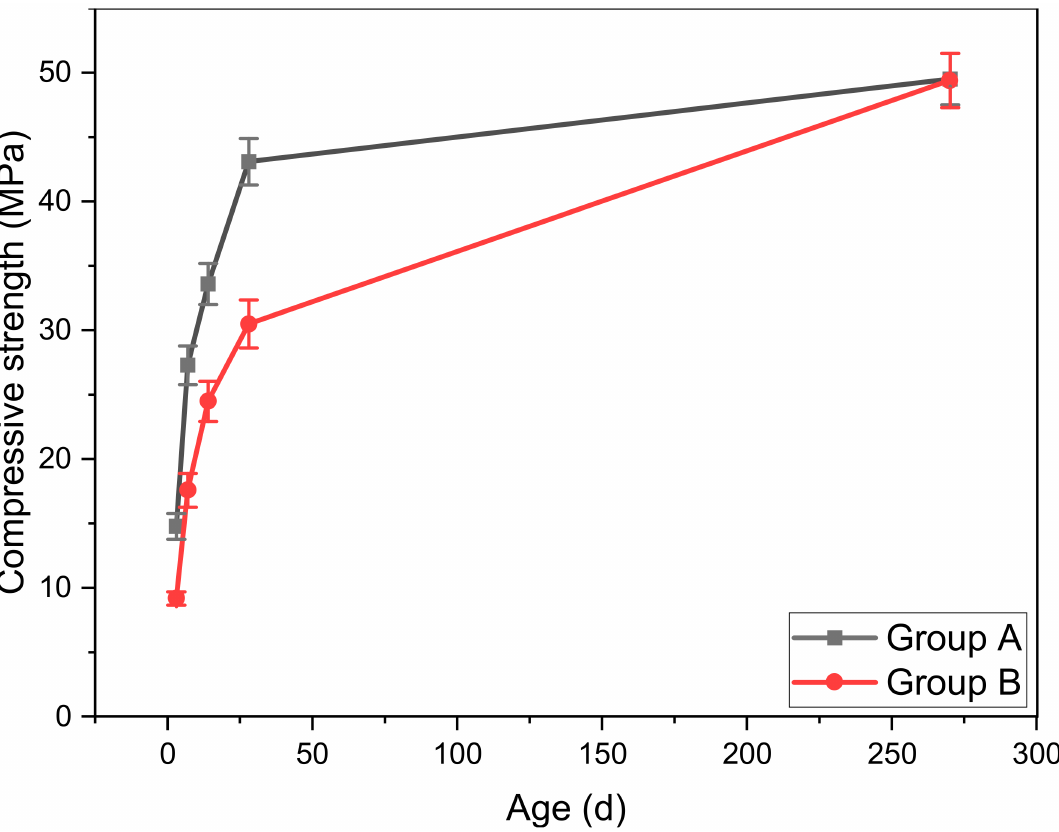
Figure 3. Compressive strength development of concrete